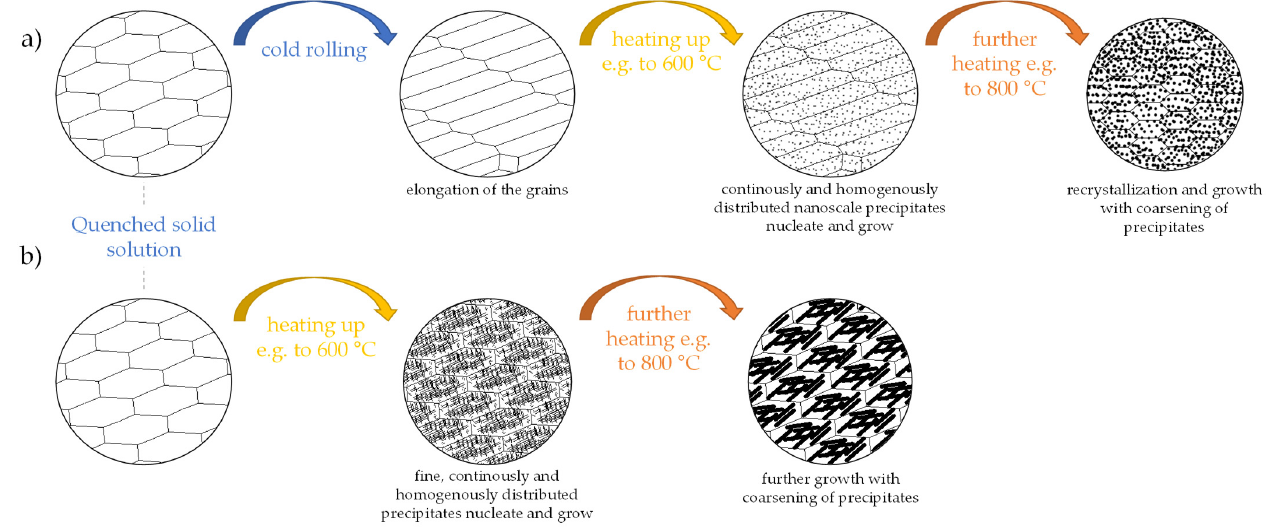
Figure 14. Schematic microstructure evolution of ( a ) CuSc0.3 and ( b ) CuHf0.7 due to continuous heating during the DSC measurements.